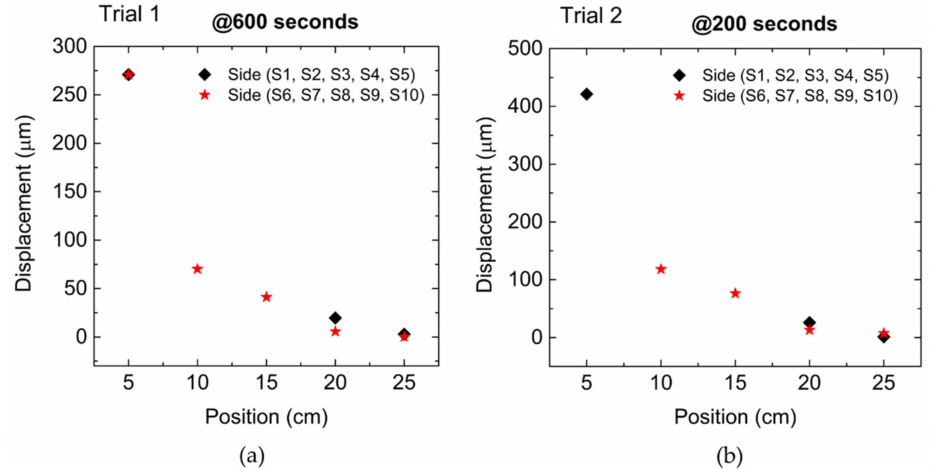
Figure 8. RB displacement measured by each FBG sensor: ( a ) At 600 s in Trial 1. ( b ) At 200 s in Trial